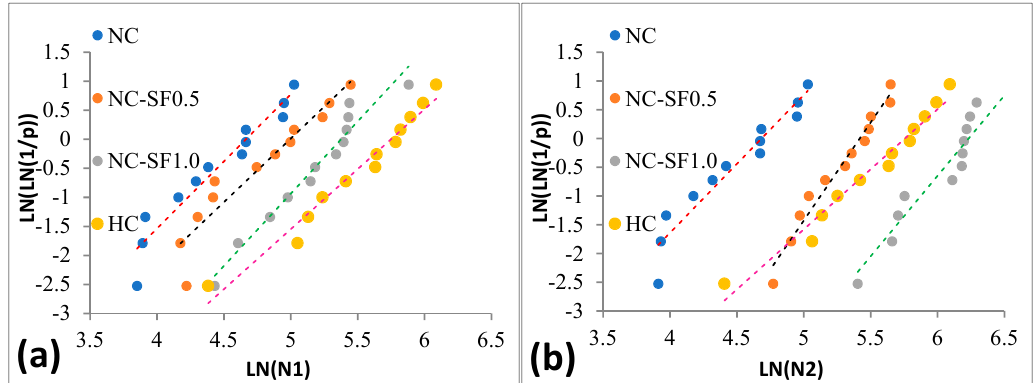
Figure 12. Regression lines from the Weibull analysis. ( a ) LN(N1), ( b ) LN(N2). The scale and shape parameters calculated were used in the evaluation that deter- Table 5. Two parameters calculated from the Weibull analysis. mined the impact strength (number of blows) corresponding to the predetermined relia- bility level. This evaluation can be written as Equation (11).